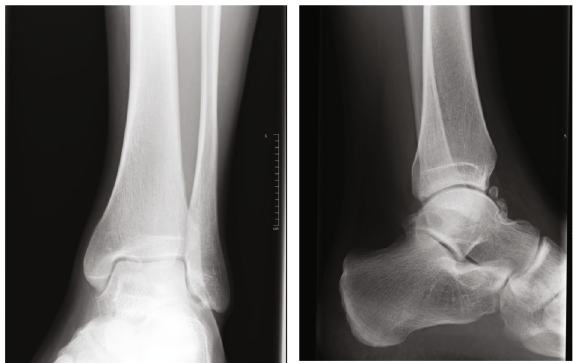
Figure 4: Mortise and lateral views of the ankle, 9 months after surgery, showing the reaccumalation of loose